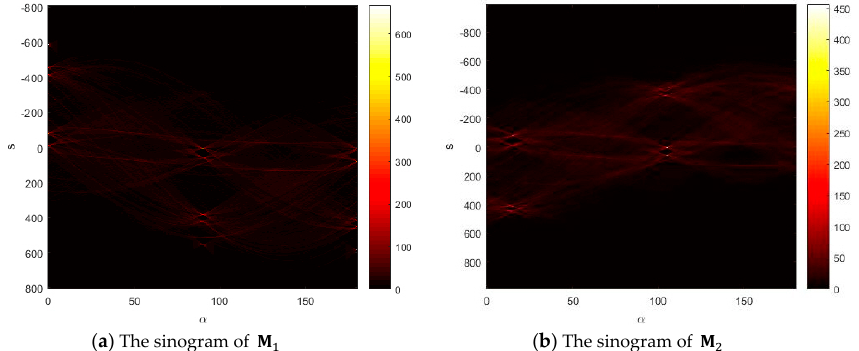
Figure 3. The sinograms of 𝐌 (cid:2869) and 𝐌 (cid:2870) . ( a ) The maximum intensity of the sinogram of 𝐌 (cid:2869) appears at (136,91 ∘ ) . ( b ) The maximum intensity of the sinogram of 𝐌 (cid:2870) appears at (997,106 ∘ ) .